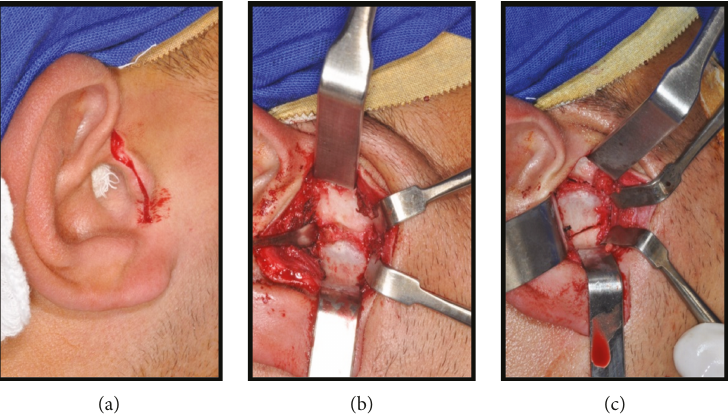
Figure 5: (a), (b), and (c) Transoperative pictures showing the endaural access and the exposure of the ankylosing mass.